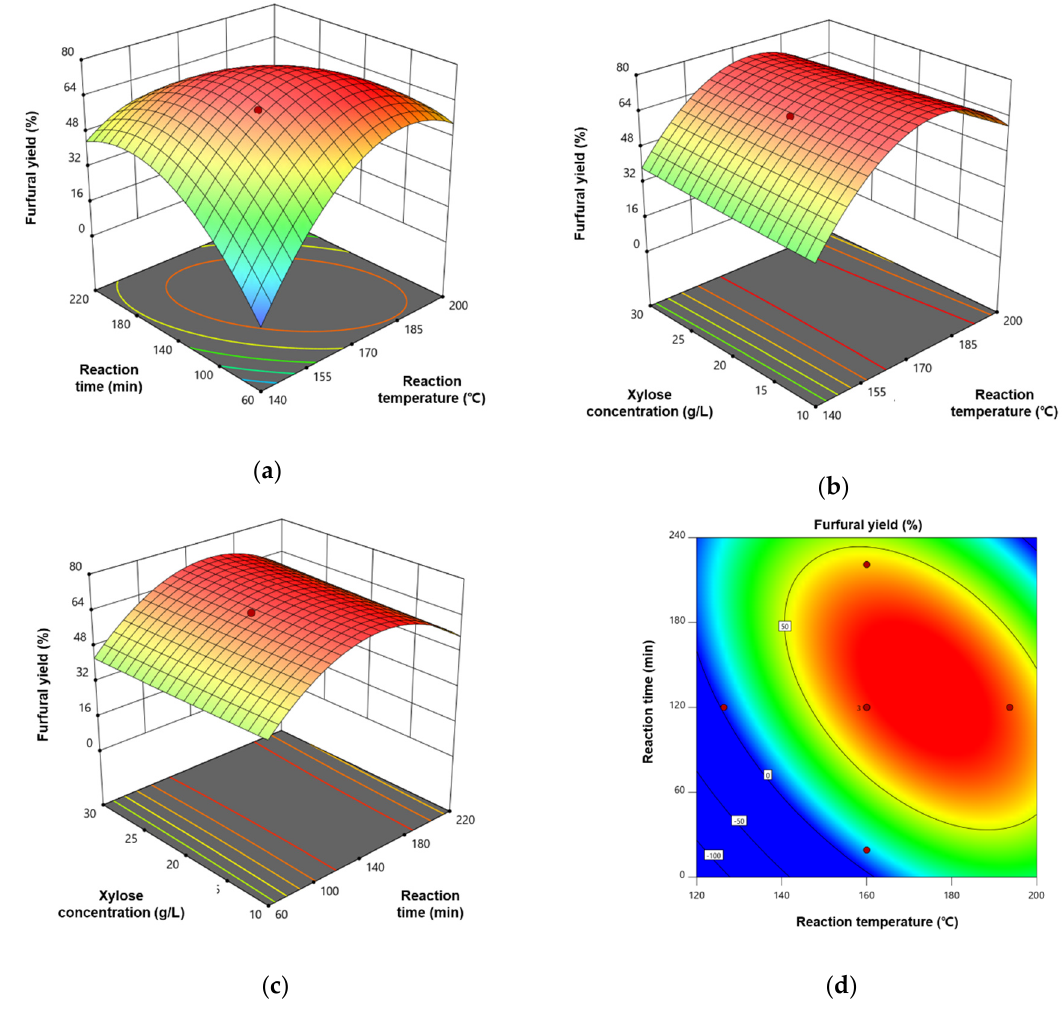
Figure 1. Three-dimensional plot and detailed contour of response surface methodology of furfural yield from xylose standard solution with extraction solvent (THF): ( a ) fixed xylose concentration (10 g/L); ( b ) fixed reaction time (120 min); ( c ) fixed reaction temperature (160 °C); ( d ) contour of furfural yield depending on reaction temperature and time.